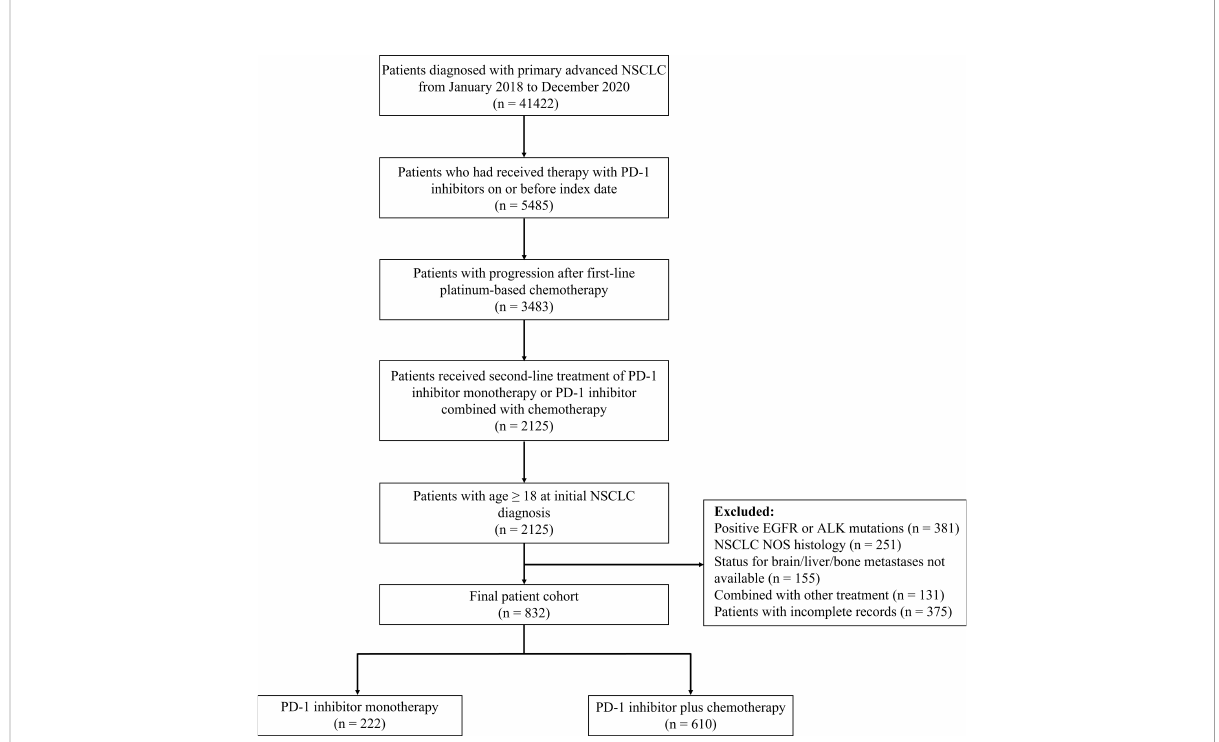
FIGURE 1 Study fl ow diagram. NSCLC, non-small-cell lung cancer; PD-1, programmed death 1; EGFR, epidermal growth factor receptor; ALK, anaplastic lymphoma kinase; NOS, not otherwise speci fi